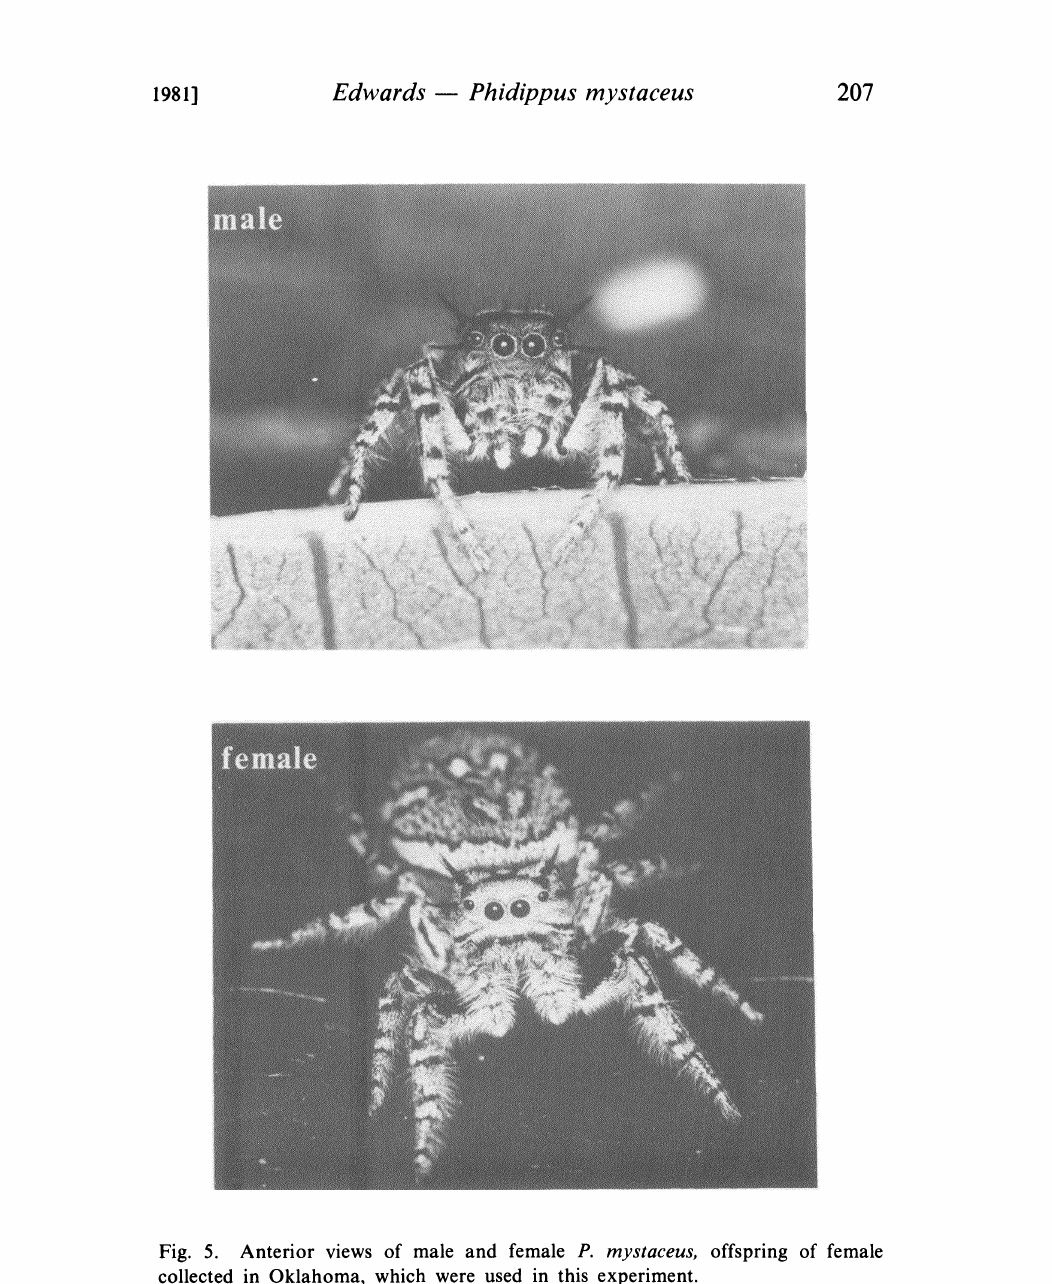
Fig. 5. Anterior views of male and female P. mystaceus, offspring of female collected in Oklahoma, which were used in this